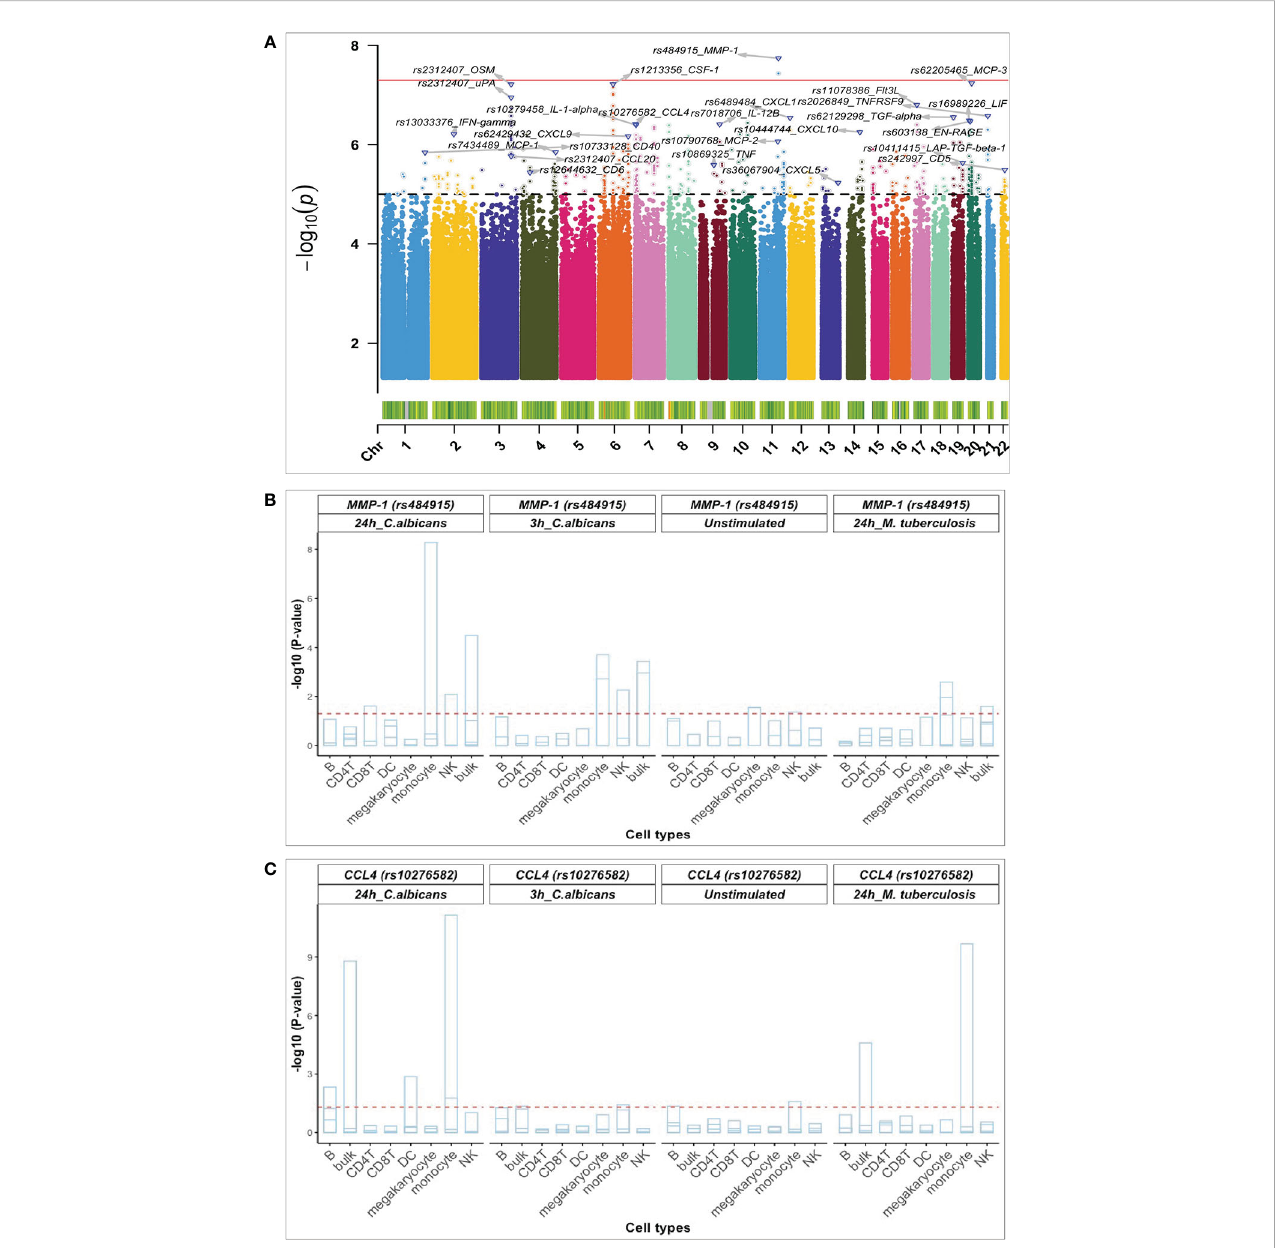
FIGURE 2 Identi fi ed pQTL SNPs and their association with cell-type speci fi c cis-eQTLs. (A) Manhattan plot of pQTL genetic variants associated with 26 proteins identi fi ed using a univariate approach and after meta-analysis. The red bold horizontal line depicts the genome-wide signi fi cant threshold (p-value < 1 x 10 -8 ) and the black dashed denotes the suggestive association threshold (p-value = 1 x10 -5 ) Top pQTL variants and their correlated proteins are displayed on the plot. Barplots of pQTL variants correlating with - MMP-1 (B) and CCL4 (C) with genome-wide signi fi cant eQTLs in monocytes. The horizontal axis shows all the cell types considered and the vertical axis represents the negative log10 p-values for eQTLs. Each strip in the barplot corresponds to gene correlating with the pQTL variants (rs484915 and rs10276582). The barplot is also grouped per stimulation and timepoints together with pQTL variants. The horizontal red dashed line corresponds to 0.05 P-value, FDR